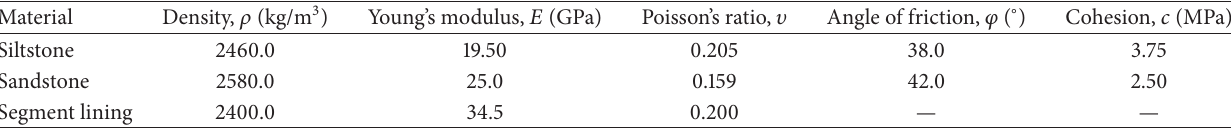
Table 1: Material parameters.